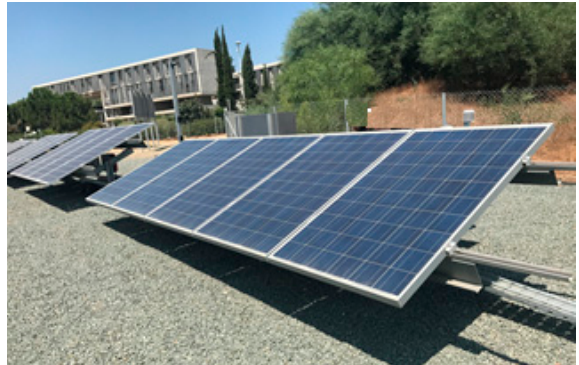
Figure 2. Test-bench PV system comprising of a polycrystalline silicon (poly-c Si) photovoltaic (PV)string, sensor network and data acquisition (DAQ) monitoring system, at the FOSS Research Centre in Nicosia, Cyprus.